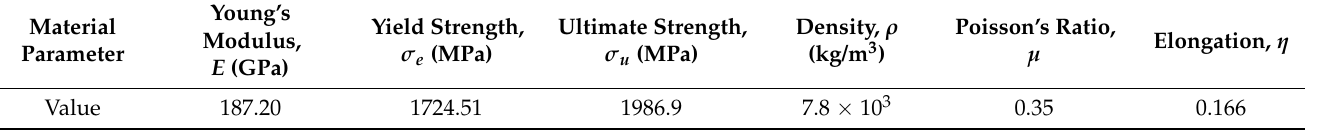
Table 1. A summary of basic mechanical properties of AerMet 100 steel.